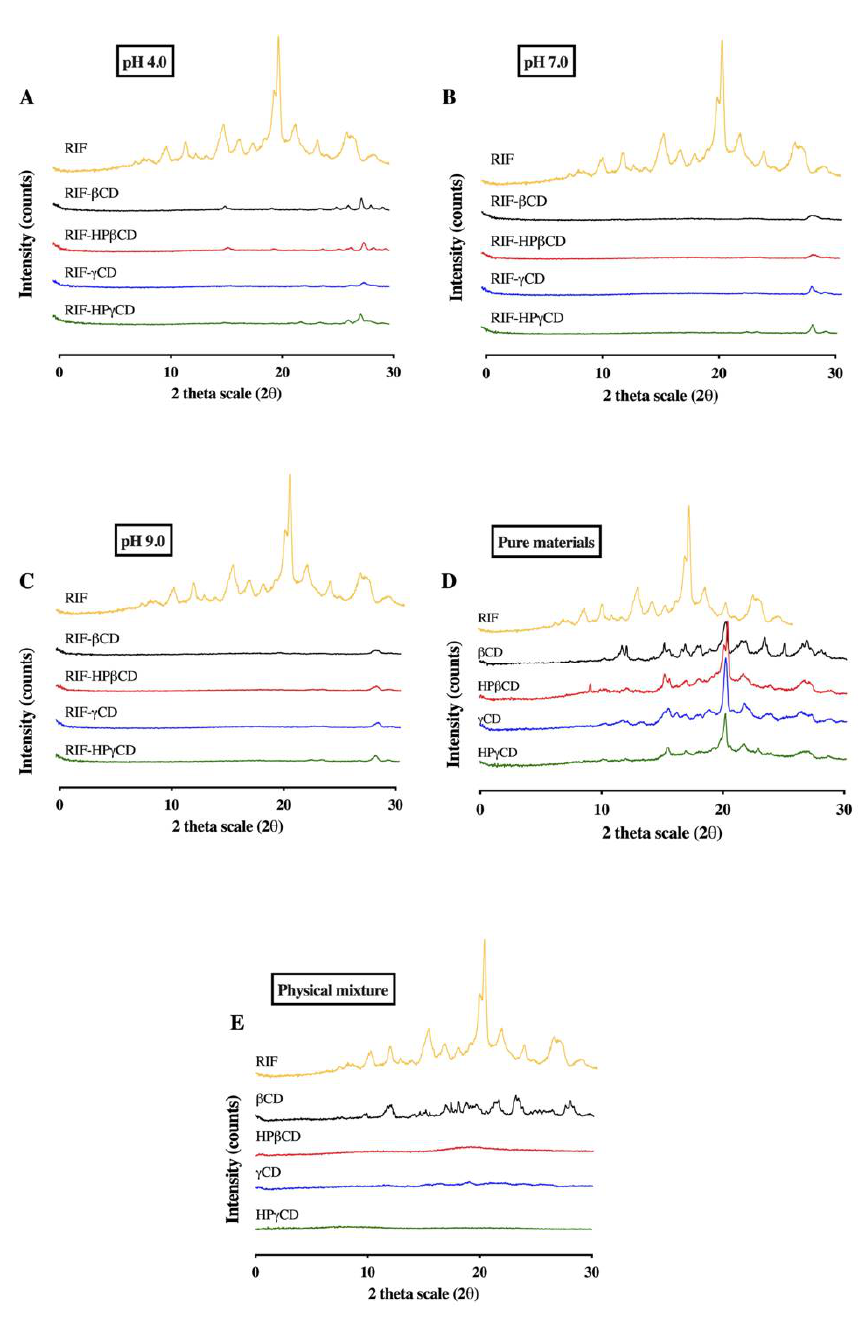
Figure 9. Representative of XRD diffractograms of RIF and several types of CD at ( A ) pH 4.0, ( B ) pH 7.0, and ( C ) pH 9.0. ( D ) The diffractograms of pure RIF, pure CD, and ( E ) physical mixture of RIF and CD.